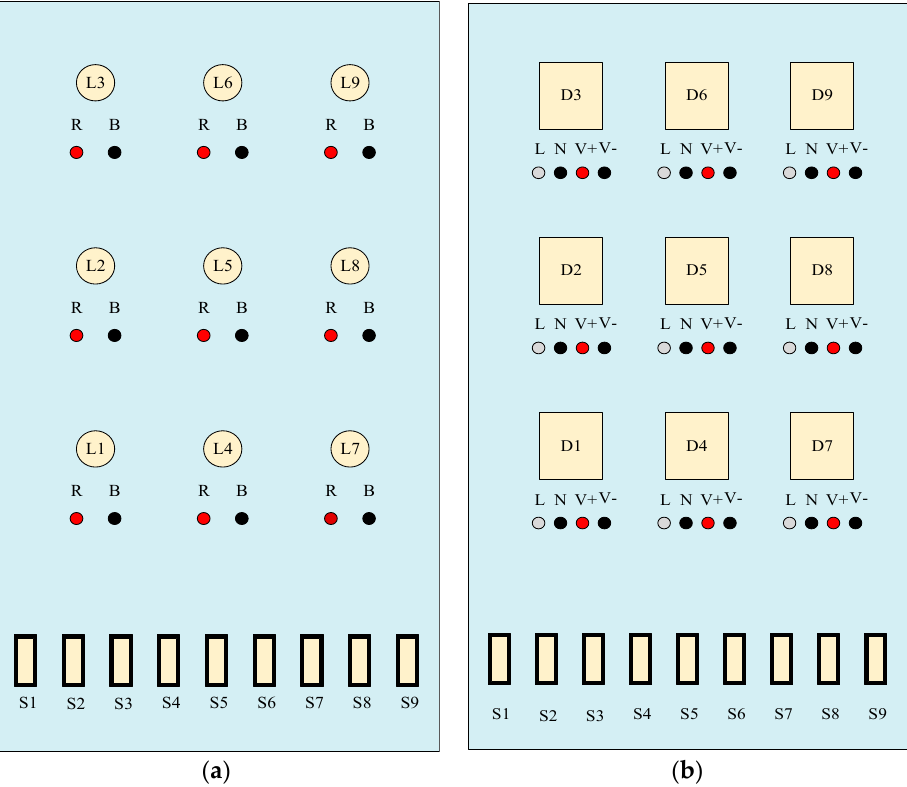
Figure 2. Schematic diagram layout of equipment in experimental setup. ( a ) Layout of the LED lamp of each layer; ( b ) Layout of LED Driver in each layer.